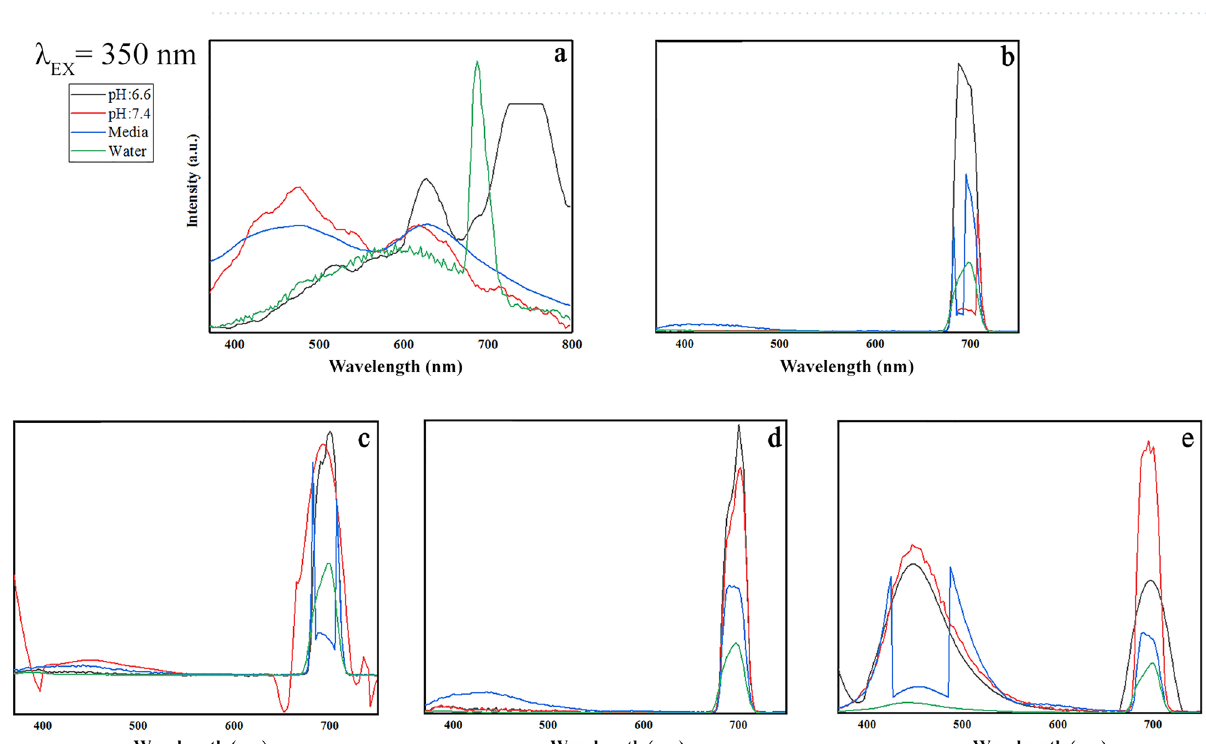
Figure 2. Emission patterns of ( a ) GO, ( b ) GO-PEG, ( c ) GO-PEG-Fe 3 O 4 , ( d ) GO-PEG-Au, and ( e ) GO-PEG-FA at the excitation wavelength of 350 nm in water, cell media (DMEM), and PBS at two different pH values (pH 6.6 and